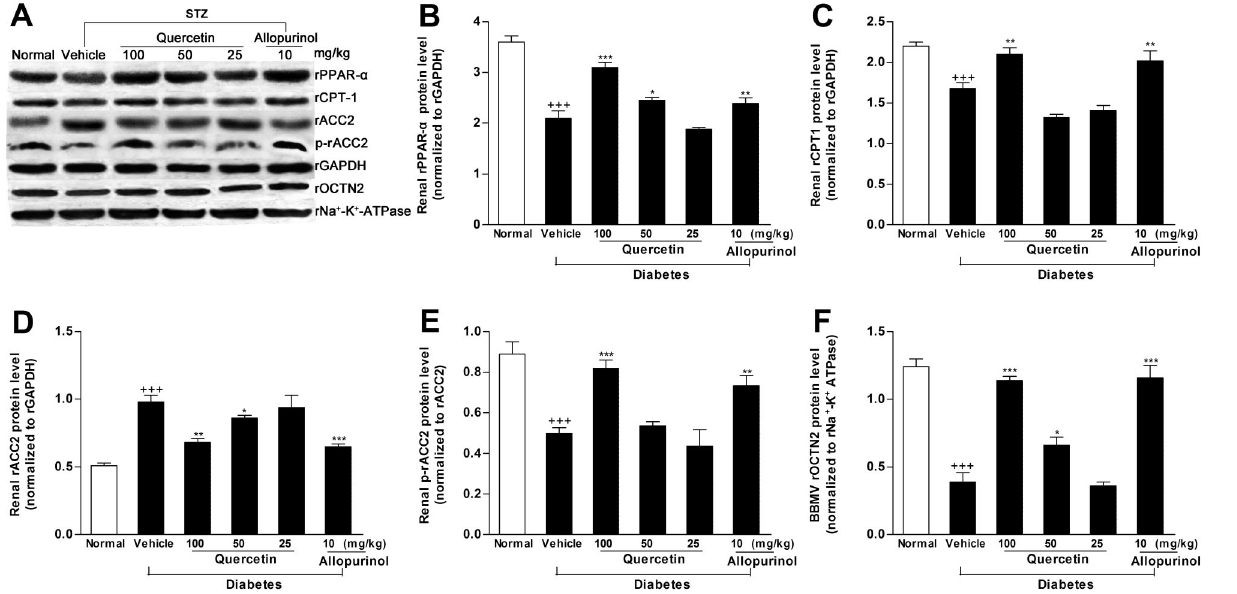
Figure 7. Quercetin and allopurinol regulate renal expression of lipid metabolism-related genes protein levels in streptozotocin (STZ)-treated rats. Representative Western blot results (A) and graphic presentation showed renal protein expression of rPPAR- a (B), rCPT1 (C), rACC2 (D), p-rACC2 (E) and rOCTN2 (F) in different groups of rats as indicated. Relative protein levels of rPPAR- a , rCPT1 and rACC2 were determined after normalization with rGAPDH. The relative renal BBMV rOCTN2 protein levels were normalized to rNa + -K + -ATPase. The data are expressed as the means 6 SEM (n=3–4). ++ P , 0.01, +++ P , 0.001 versus normal control; * P , 0.05, ** P , 0.01, *** P , 0.001 versus STZ control.